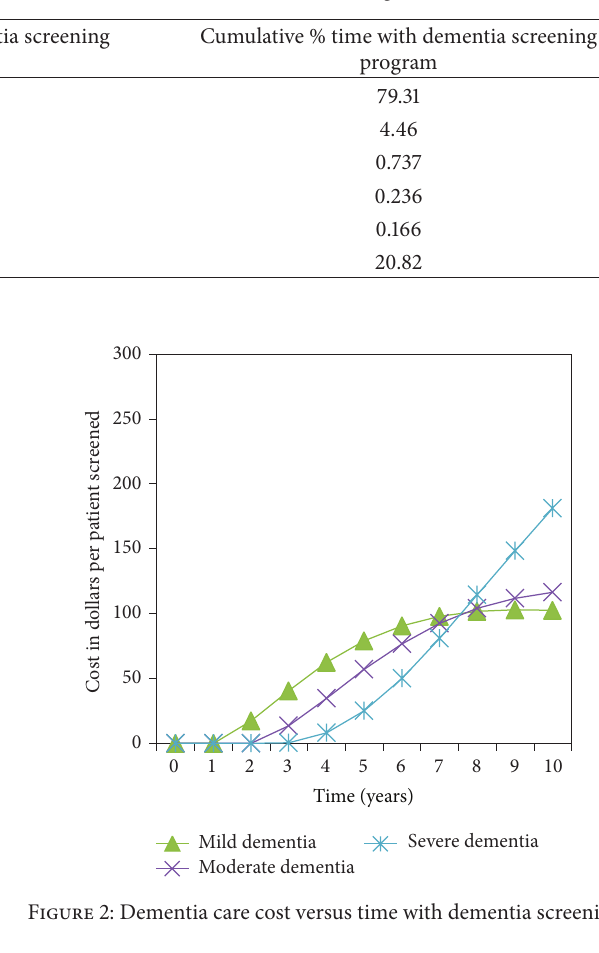
Table 3: Cumulative percent time in disease state with and without dementia screening.